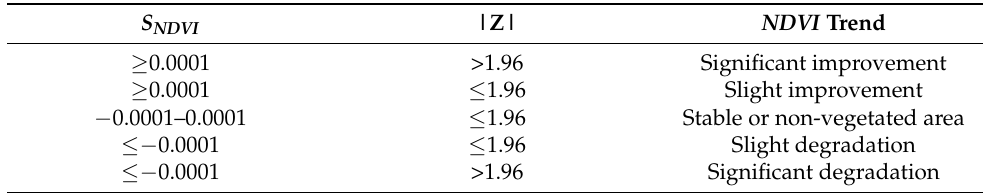
Table 3. Division and statistics of the NDVI variation